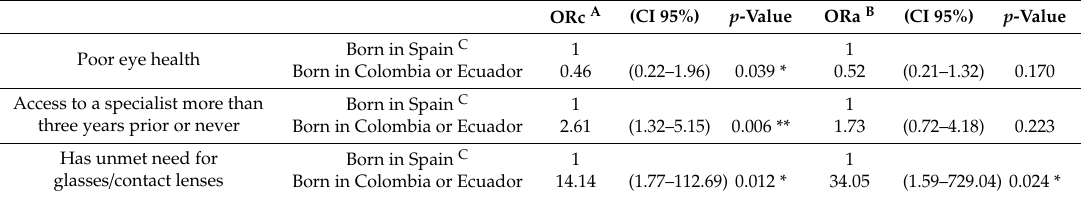
Table 4. Logistic regression model of poor eye health, access to a specialist more than three years prior or never, and unmet need for corrective lenses in workers included in the study by country of